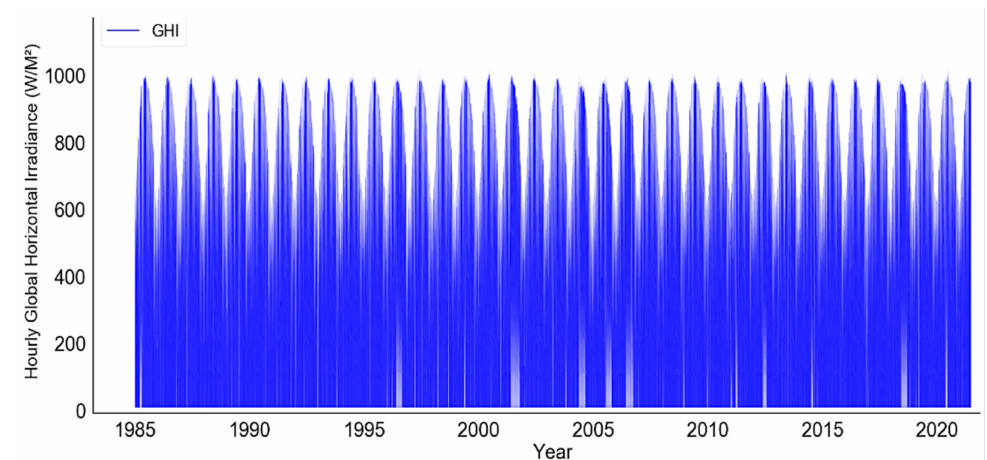
Figure 8. Hourly intervals historical performance of the GHI over 36 years.